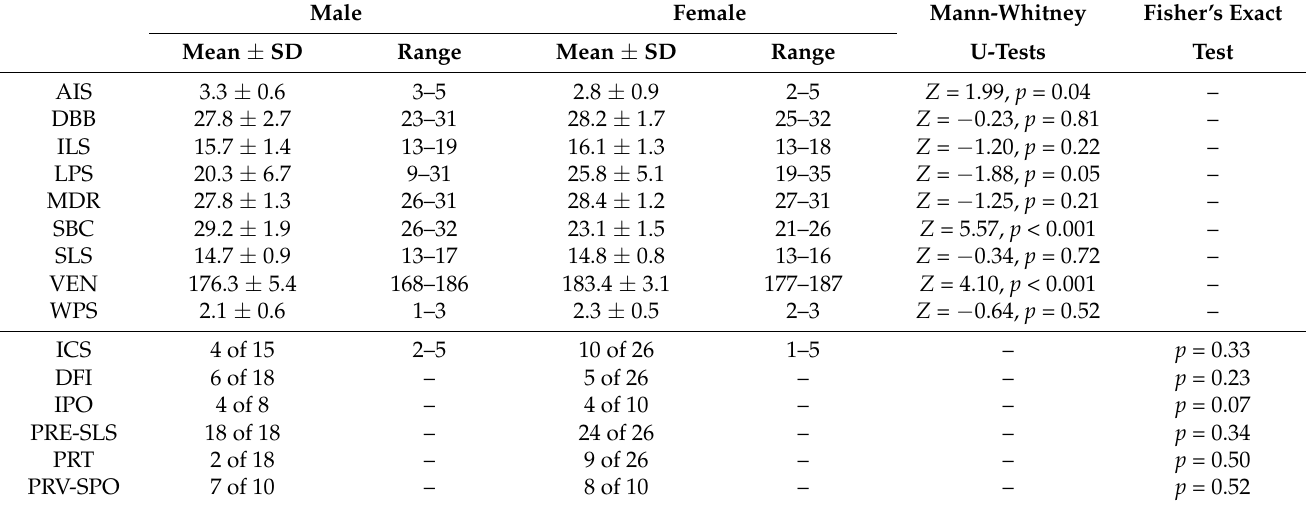
Table 3. Morphological character counts of male and female Tehuantepec Isthmus rattlesnake ( Crotalus ehecatl ; n = 47). Abbreviations are: AIS = anterior intersupraoculars, DBB = dorsal body blotches, DFI = divided first infralabial scale, ICS = intercanthal scales, ILS = infralabial scales, IPO = interpreocular scale, LPS = number of scales lengthwise on the paravertebral stripes, MDR = midbody dorsal scale rows, PRE-SLS = contact between the prenasal and the first supralabial scales, PRT = postrostral scale, PRV-SPO = contact between paravertebral stripes with supraoculars scales, SBC = subcaudal scales, SD = standard deviation, SLS = supralabial scales, VEN = ventral scales, WPS = number of scales widthwise on paravertebral